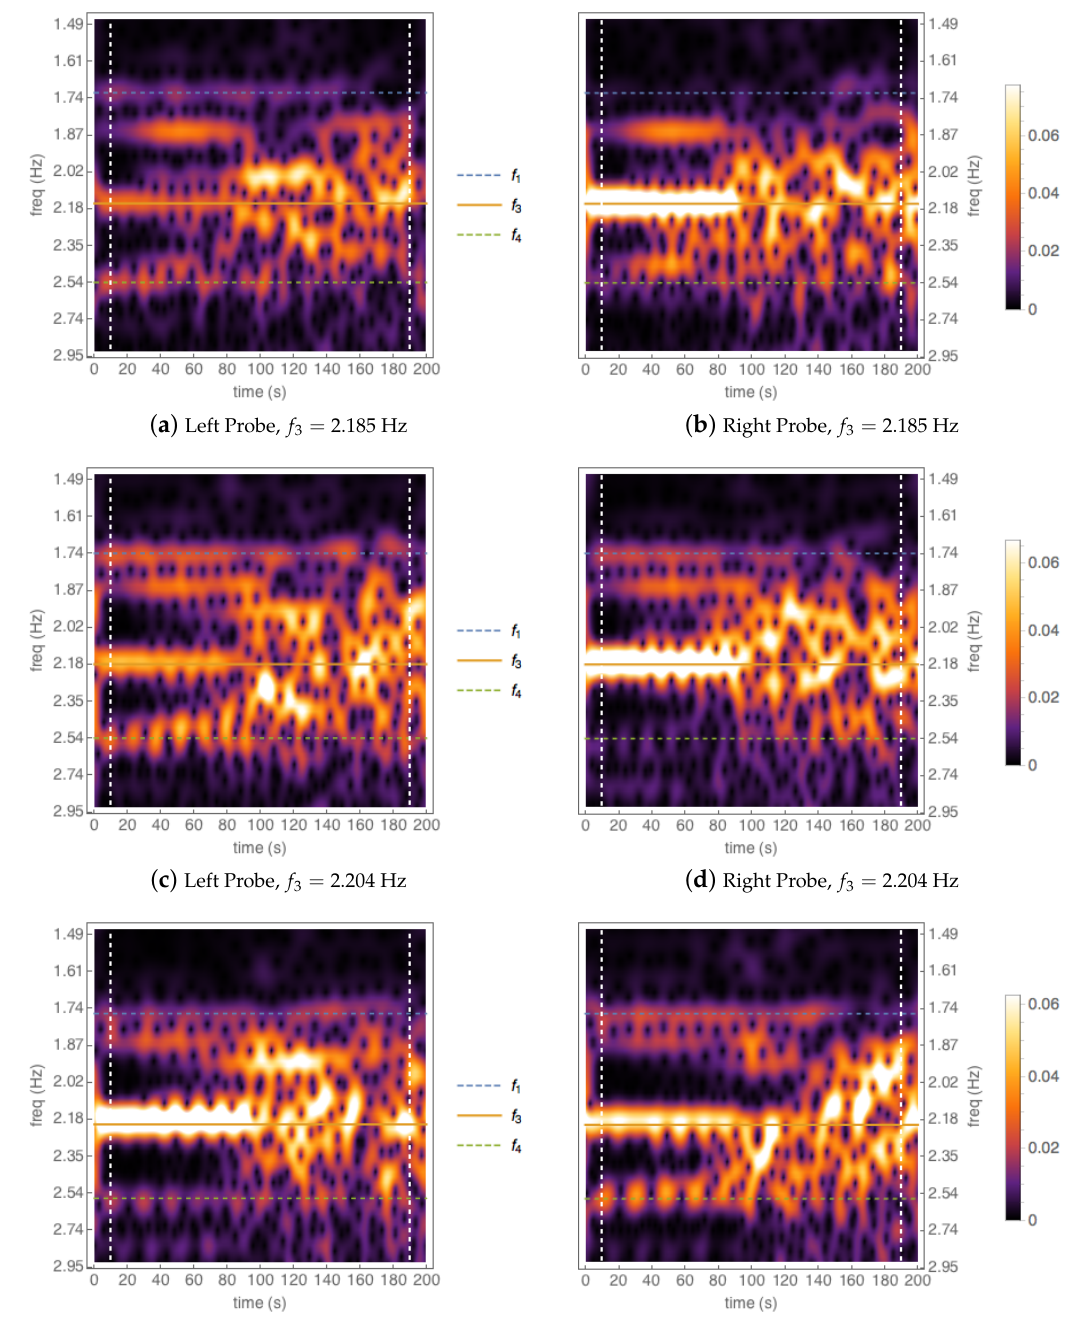
Figure 10. Scaleograms for measurements of probe 1 ( left panels ) and probe 2 ( right panels ), for three numerical wave packet experiments close to the resonance. Frequencies are displayed in the vertical axis and time in the horizontal axis. Horizontal lines represent the theoretical frequencies f 1 , f 3 and f 4 stemming from the dispersion relation f ( k ) = for the wavevectors K 1 = K 3 − K 2 , K 3 and K 4 = K 3 + K 2 . The rows from top to bottom correspond to experiments with f 3 / Hz = 2.185,2.204,2.220 chosen to correspond to the time series in Figure 9. Vertical lines represent the initial and final times t = 10 s, 190 s for the calculation of the efficiency to the target mode f 1 that avoids spurious boundary